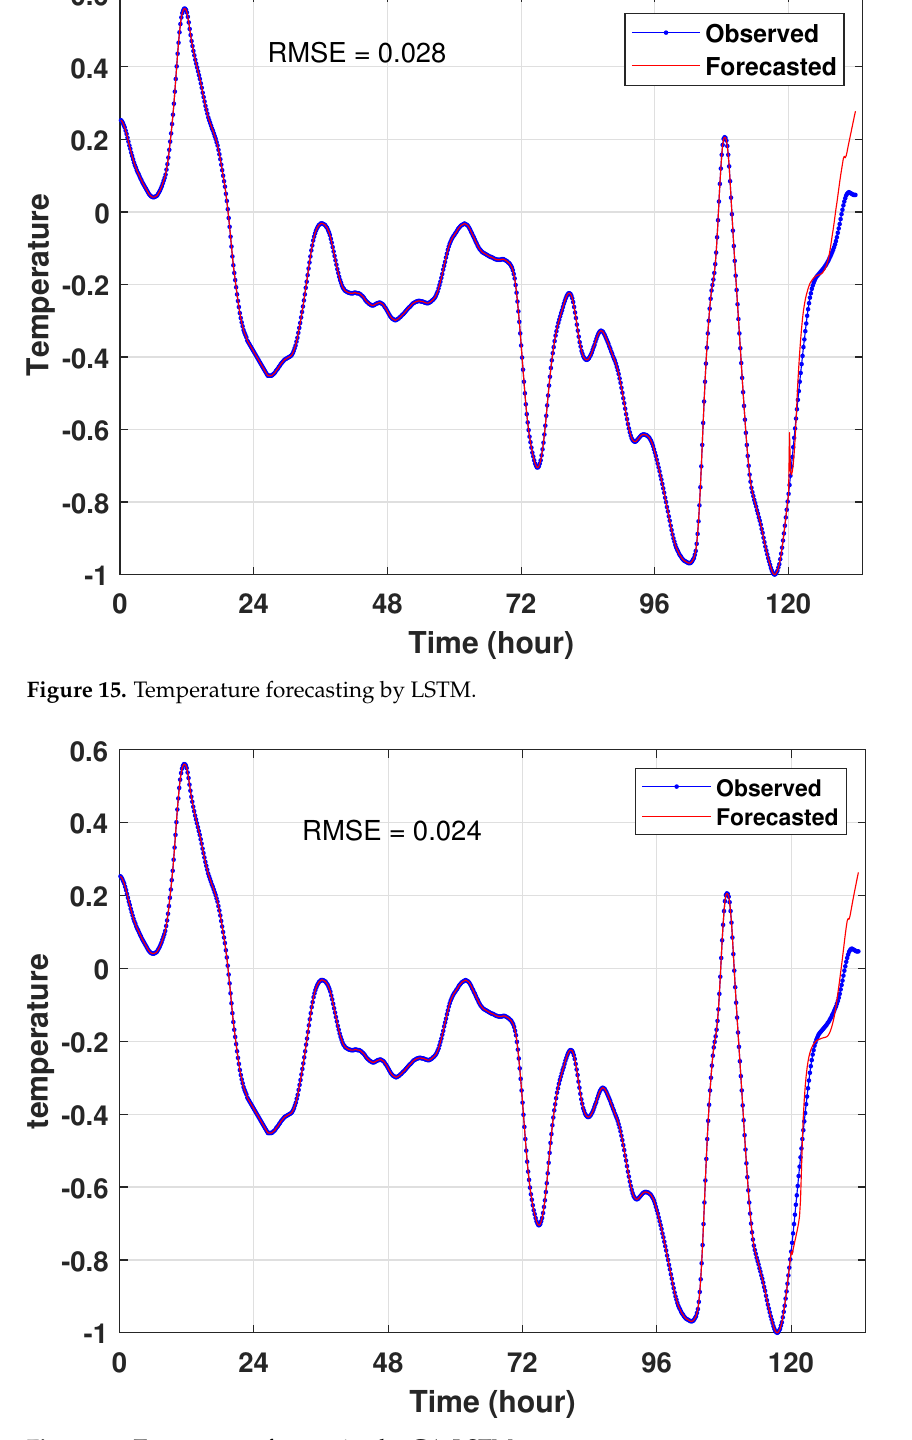
Figure 16. Temperature forecasting by